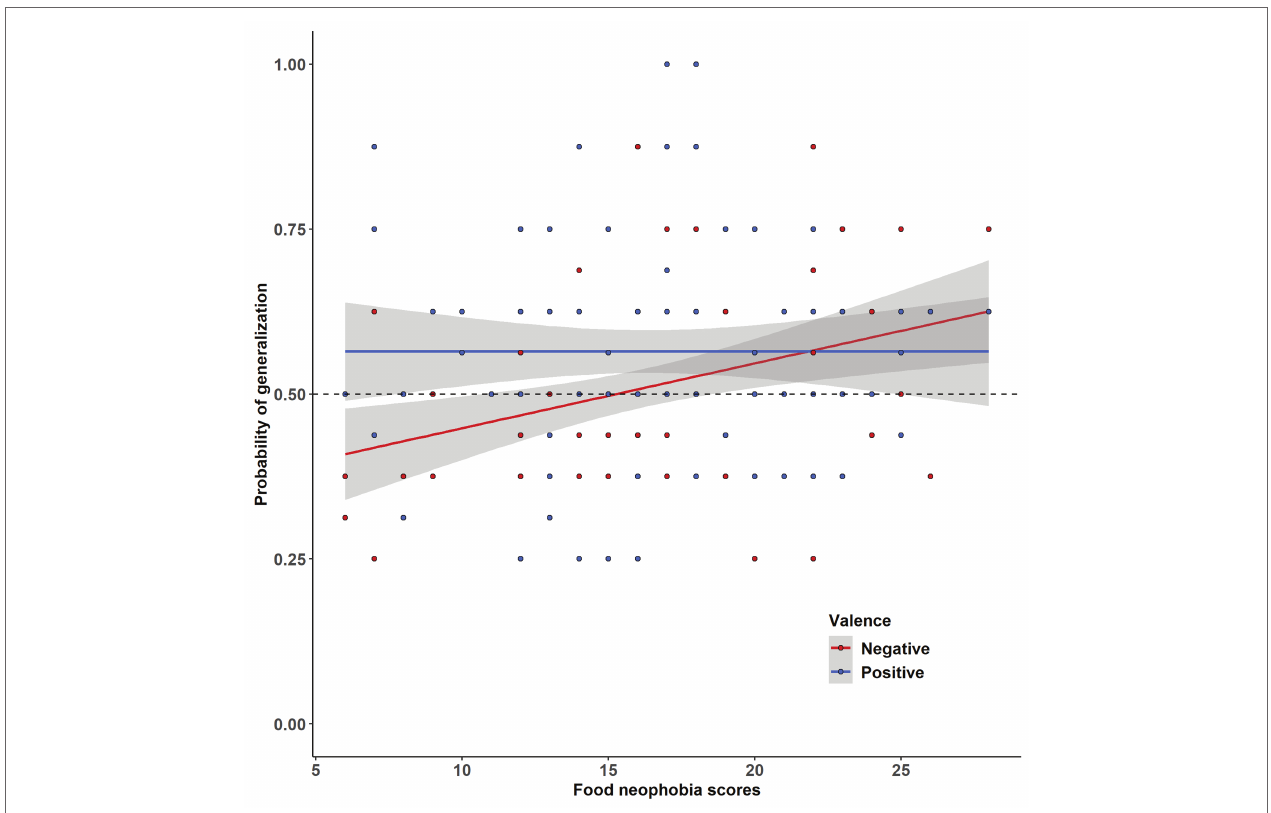
FIGURE 5 | The probability of properties generalization as a function of Food Neophobia scores [as attested by the Child Food Rejection Scale (CFRS)] and